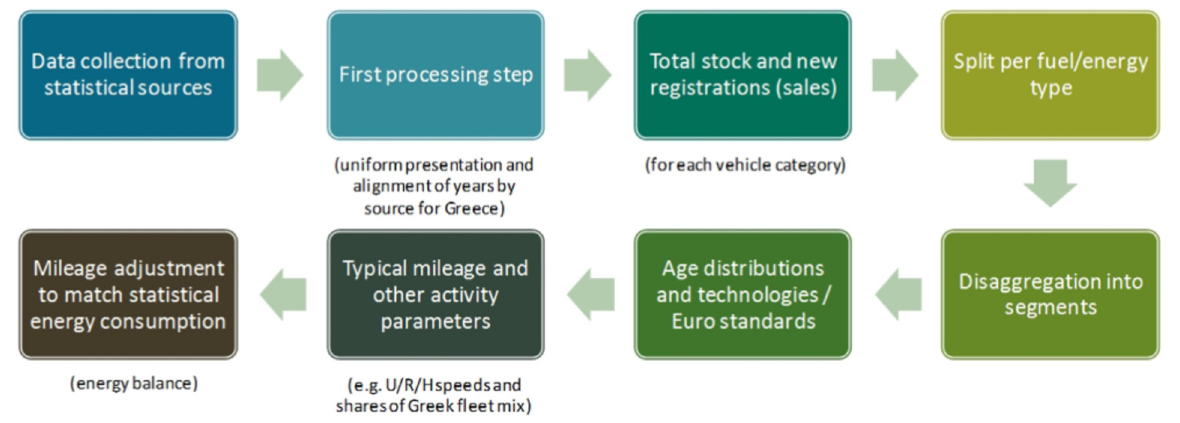
Figure 4. Vehicle fleet scenario development method. Reprinted with permission from ref. [70]. Copyright 2022 Elsevier.